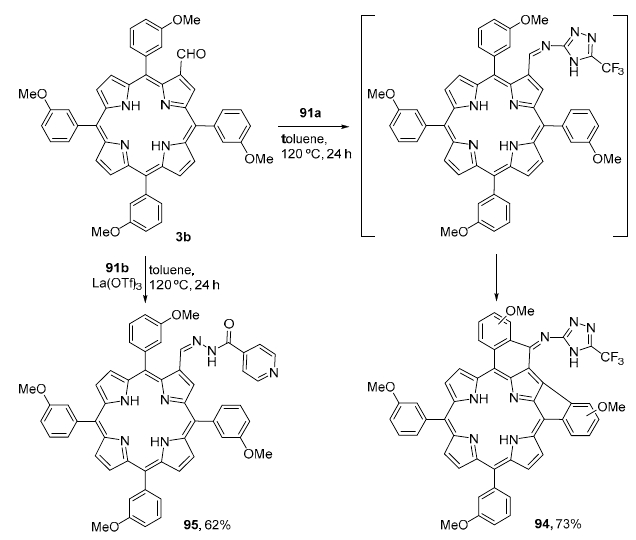
Scheme 23. Reaction of β -CHO- m -MeOTPP with aminotriazole 91a and isoniazid